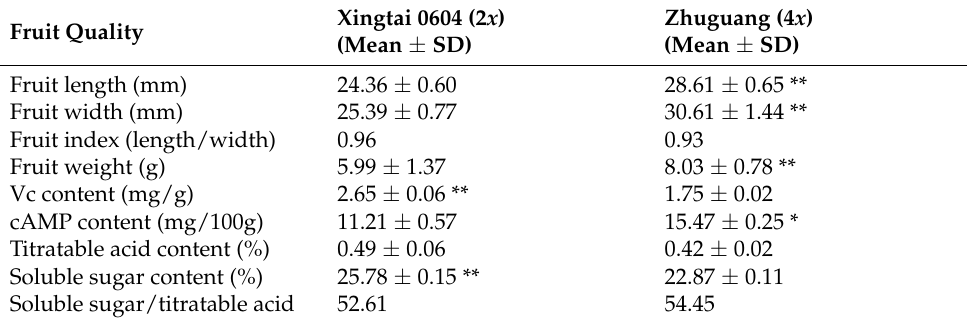
Table 4. Fruit characteristics and q uality of ‘Xingtai 0604′ and ‘Zhuguang’ . Fruit Quality